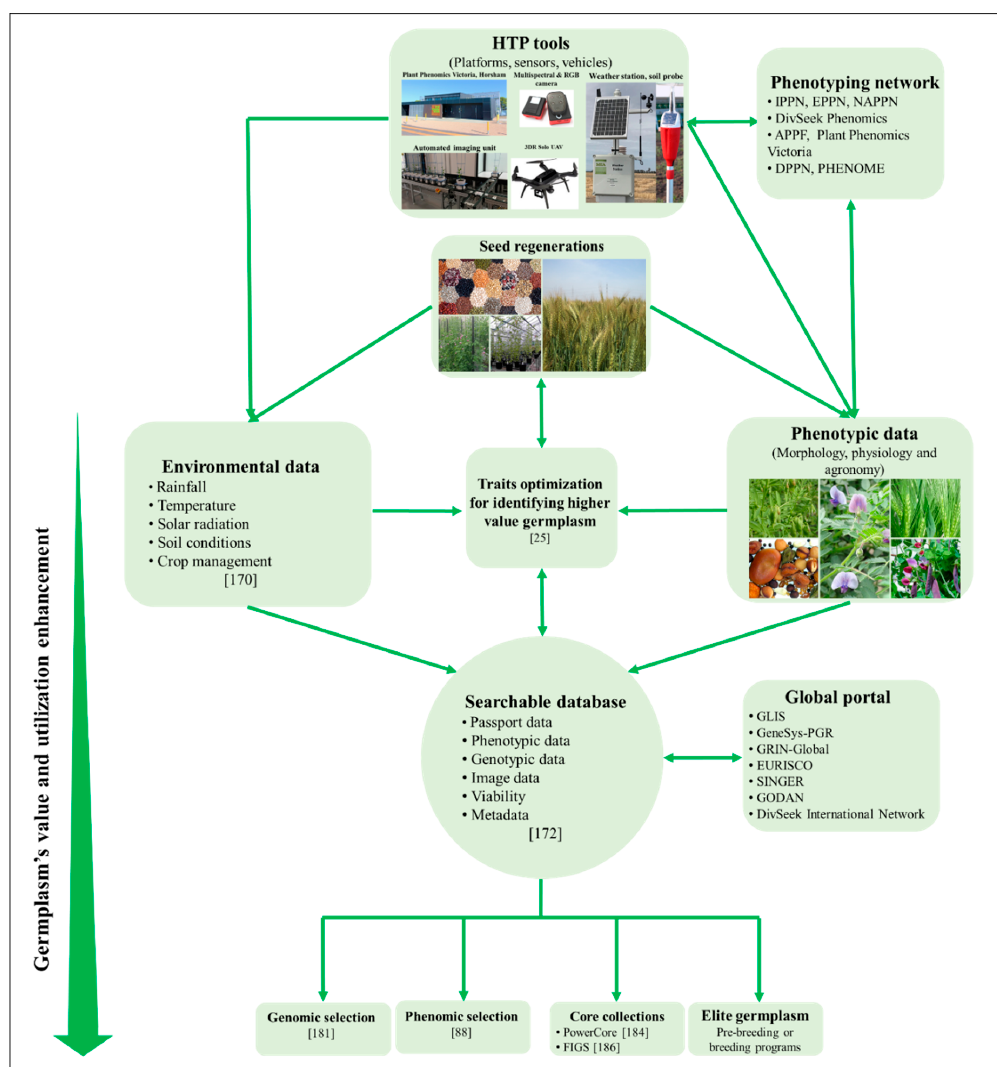
Figure 1. A proposed strategic phenomic approach to improve the value and utilization of genetic resources. IPPN, international plant phenotyping network; EPPN, European plant phenotyping network; NAPPN, North American plant phenotyping network; APPF, Australian plant phenotyping Facility; DPPN, German plant phenotyping network; PHENOME, French plant phenomic infrastructure; GLIS, global information system; GeneSys-PGR, global portal on crop genetic Resources; GRIN-Global, global germplasm resource information network; EURISCO, European plant genetic resources search catalogue; SINGER, system-wide information network for genetic resources; GODAN, global open data for agriculture.